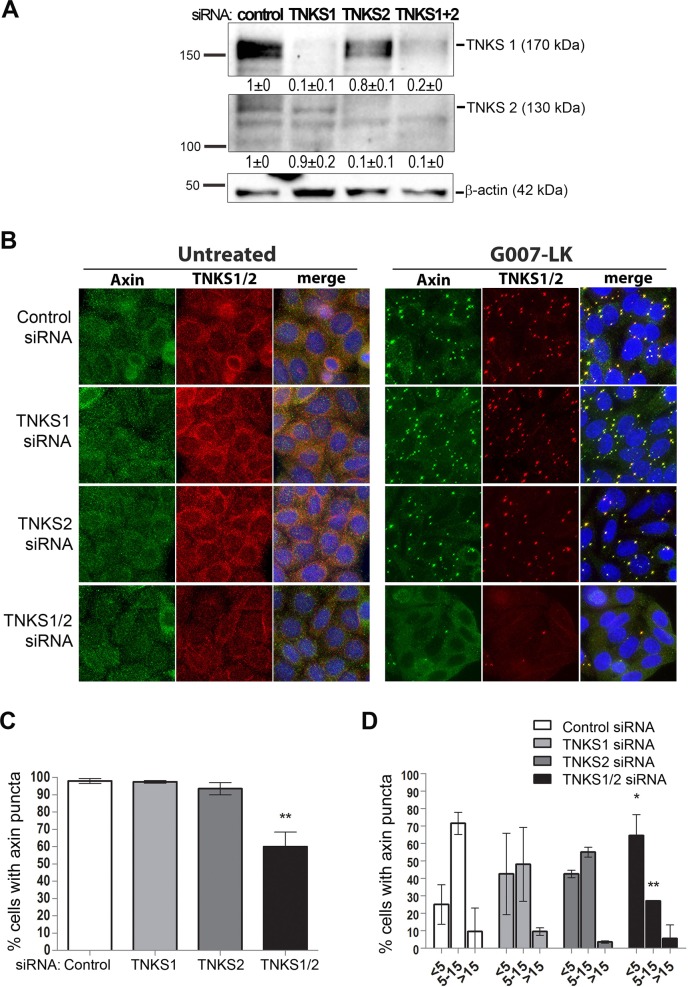
TNKS expression is required for TNKSi-dependent assembly of axin puncta.The effect of silencing expression of TNKS1, TNKS2 or both (TNKS1/2) by siRNA was examined on TNKSi induced puncta formation in SW480 cells. A. Western blot and quantification showing the differences in TNKS expression after knockdown of the individual TNKSs. The band intensities represent the mean ± SD (normalized to actin) of two independent experiments. B. Immunofluorescence staining of SW480 cells untreated or treated for 24h with 5 μM of the TNKSi G007-LK. The individual knockdown of TNKS1 or TNKS2 did not significantly alter axin puncta formation, but the combined silencing of both TNKS1 and TNKS2 (siTNKS1/2) caused a clear reduction of cells showing axin and TNKS-positive puncta after G007-LK treatment, as shown by the cell images. C. A general scoring for axin puncta formation by microscopy revealed a ~40% decrease in the % cells showing visible axin puncta but only after silencing of both TNKS-1 and -2 (one-way anova bonferroni post-test, ** p<0.01 shows significance in comparison to the control). Only small differences were observed after knockdown of the individual TNKS. D. A more detailed comparison of the impact of TNKS expression on puncta was performed by scoring the range of puncta present per cell (categories: <5, 5–15 or >15 puncta). Here small reductions in the number of puncta per cell were seen with the individual TNKS siRNAs, but again only the double knockdown caused a significant reduction (two-way anova bonferroni post-test * p<0.05 and ** p<0.01 shows significance relative to control) in the number of puncta per cell.